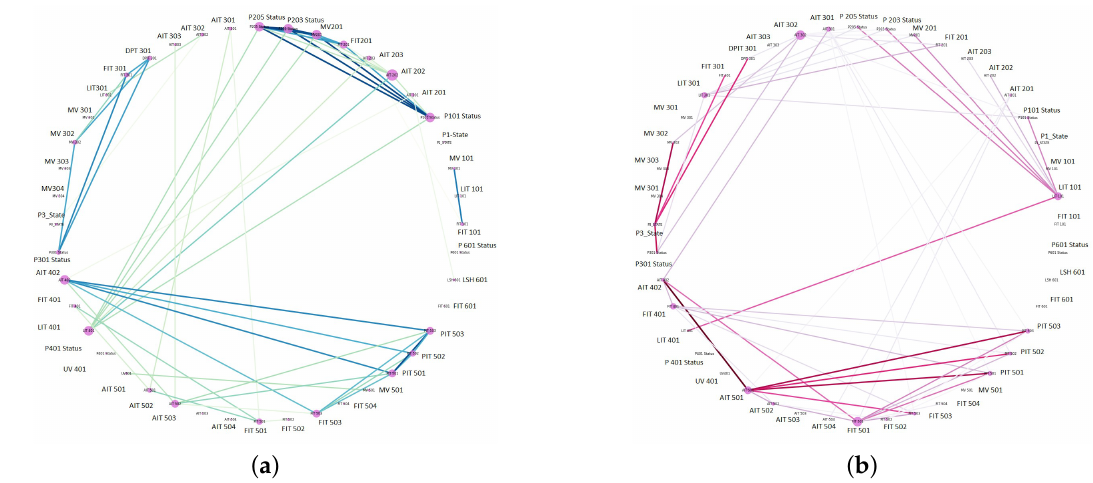
Figure 11. SWaT positive and negative correlations: ( a ) Positive ( > 0.5), ( b ) Negative ( < − 0.5).